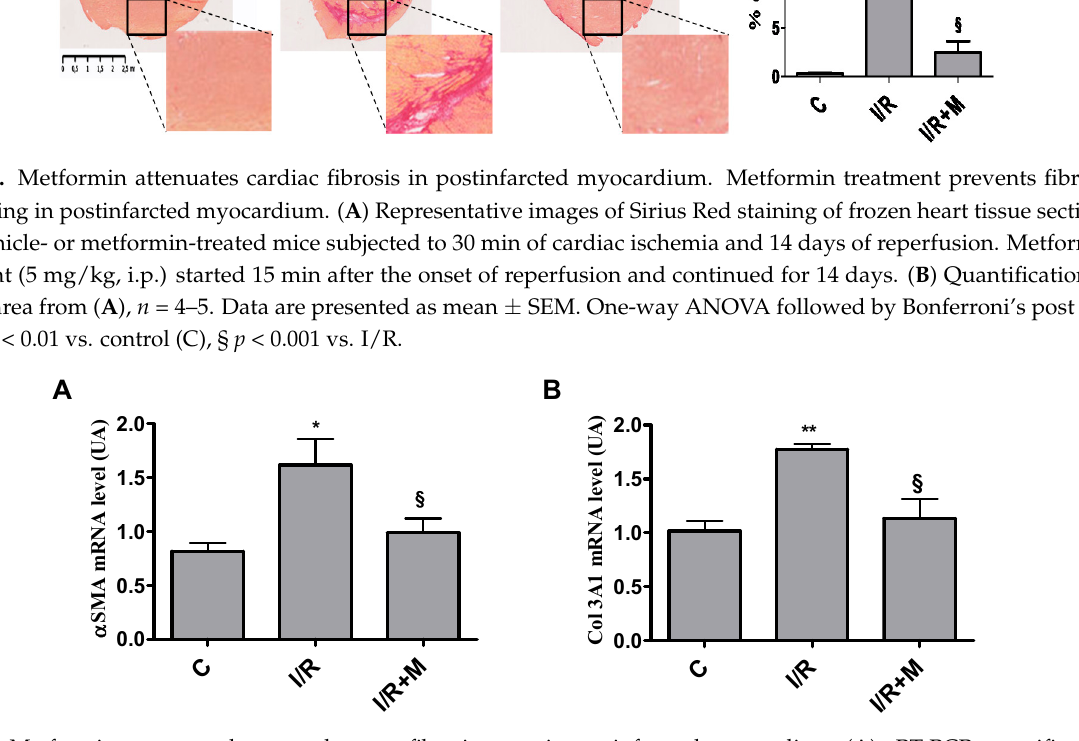
Figure 3. Metformin treatment downregulates profibrotic genes in postinfarcted myocardium. ( A ) qRT-PCR quantification of the expression level of the myofibroblast marker α SMA. ( B ) qRT-PCR quantification of the expression level of the collagen type III. Data are presented as mean ± SEM. One-way ANOVA followed by Bonferroni’s post hoc test: * p < 0.05 vs. control (C), ** p < 0.01 vs. control (C), § p < 0.05 vs. I/R.